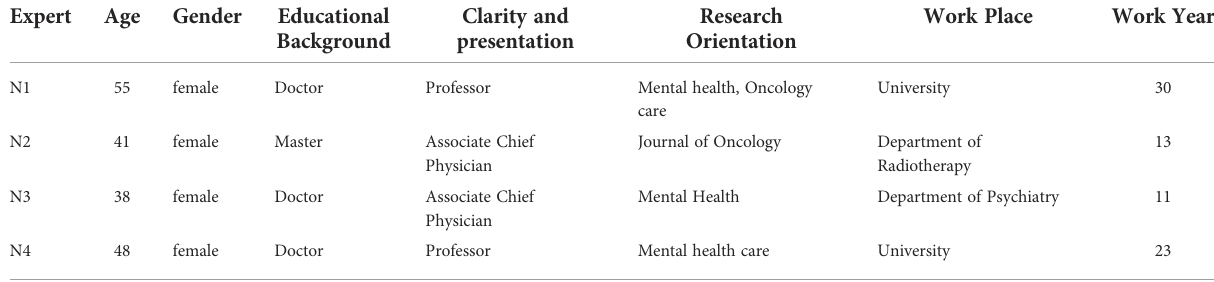
TABLE 2 Experts information for evaluating of included